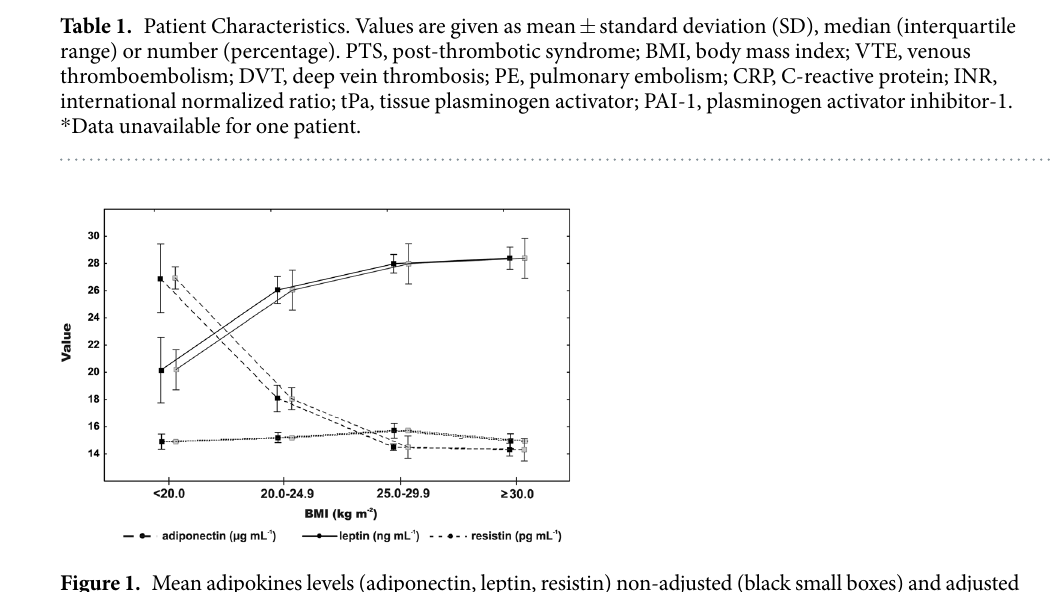
(Table 1). A similar trend was observed in non-obese patients, i.e.13.1% lower adiponectin (p < 0.001) and 20% higher leptin (p < 0.001) when compared individuals with PTS versus those without PTS. This was also true for